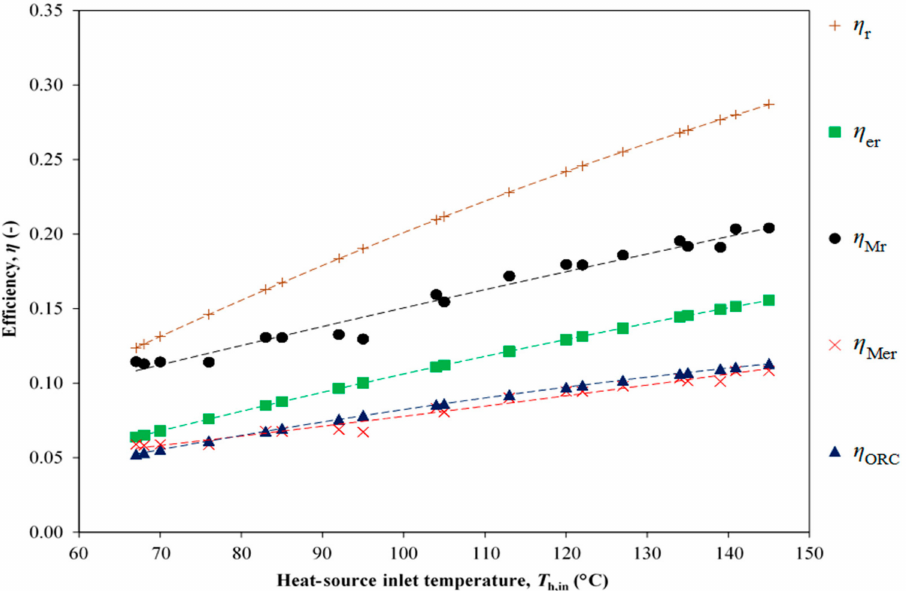
Figure 7. Predictions of ORC engine e ffi ciencies from the empirical model (Equation (8)) and theoretical e ffi ciency models as a function of the heat-source inlet temperature (from 65 to 145 ◦ C), when utilizing the thermal energy from the streams listed in Table 5. The heat sink is assumed to be at 25 ◦